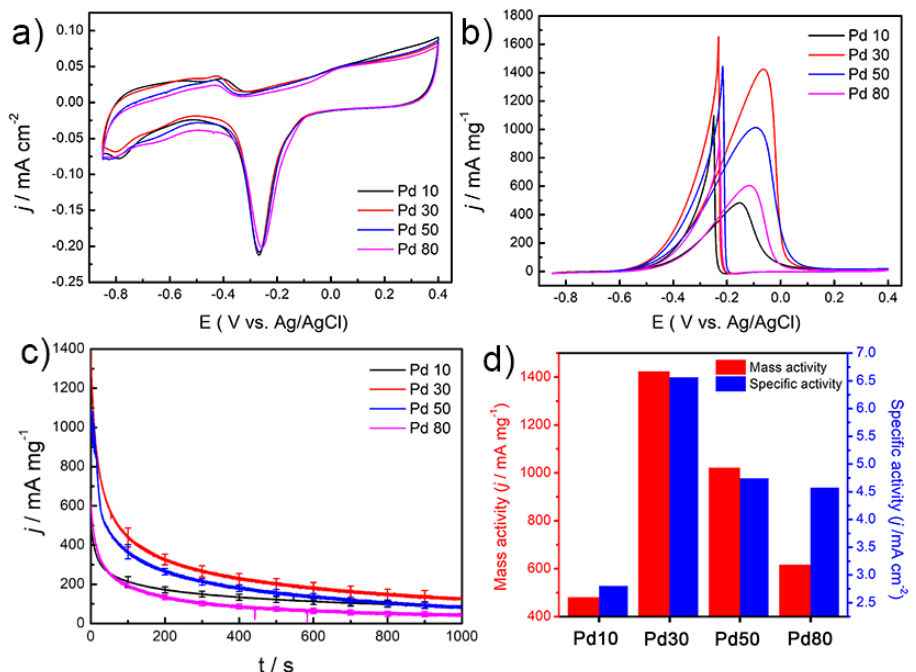
Figure 4. CV of ( a ) Pd NPs on carbon electrodes with a scan rate of 50 mVs − 1 in 0.1 M KOH. ( b ) CV for the ethanol electrooxidation reaction on different electrodes in 0.5 M ethanol +0.5 M KOH with scan rate of 50 mVs − 1 . ( c ) Chronoamperometric curves and the error bars based standard deviation for the ethanol electrooxidation reaction at − 0.1 V versus Ag/AgCl on a Pd NP electrode for Pd10, Pd30, Pd50 and Pd80 in a 0.5 M ethanol +0.1 M KOH solution. ( d ) Current performances for ethanol oxidation on the four other sizes of catalyst.